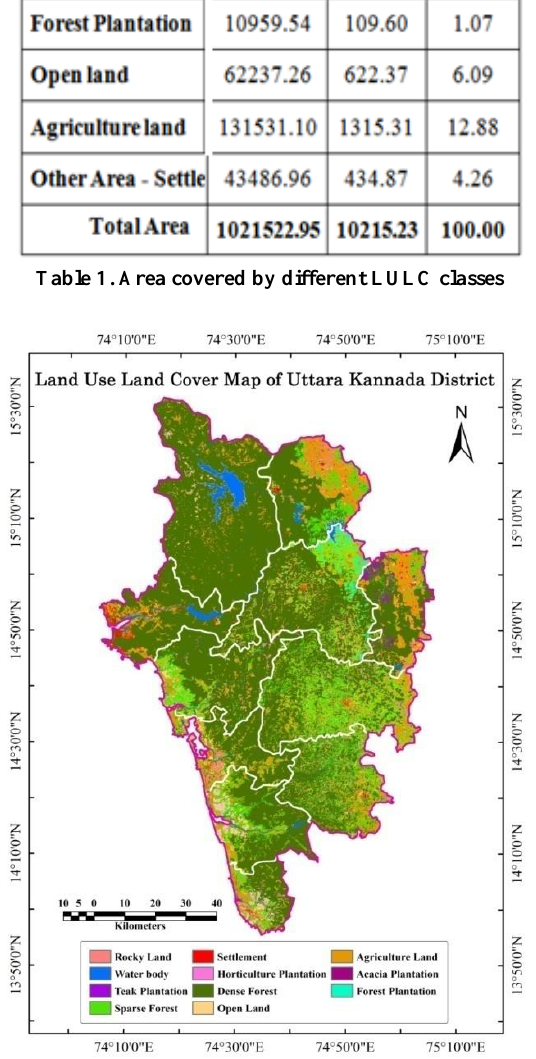
Figure 2. Land use land cover